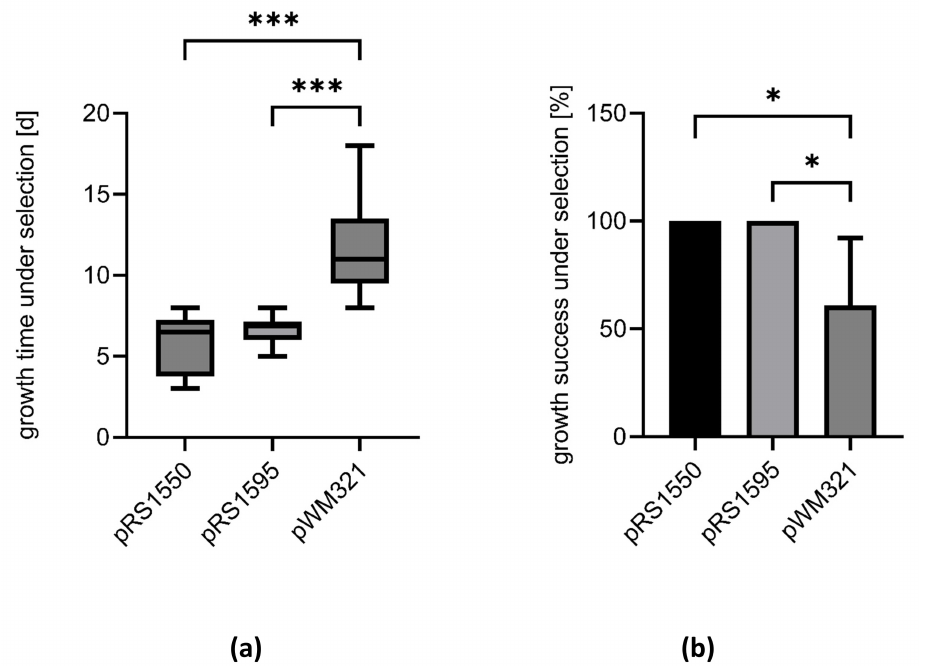
Figure 2. Transformation success in M. mazei . The wild type strain M. mazei * was transformed with pWM321, pRS1550 or pRS1595 using liposome-mediated transformation. ( a ) After the addition of selective pressure, the days were counted until visible growth appeared. ( b ) Growth success of different cultures under selective pressure (puromycin) after transformation. The cultures that have grown have been set in relation to those that have not grown within four weeks. Data represent mean values from 3–6 biological replicates and 2–3 technical replicates each, with standard deviations shown as error bars. The significance was calculated in a one-way ANOVA followed by Dunnett’s multiple comparisons test with p-values resembled as stars with * p < 0.05 and *** p < 0.001 using GraphPad Prism version 9.4.1 for Windows, GraphPad Software, San Diego, CA, USA, www.graphpad.com (accessed on 11 August